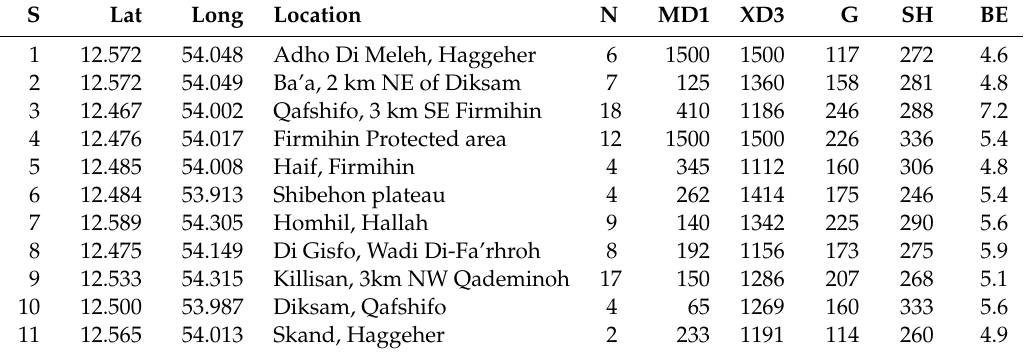
Table 1. Details of the sites and variables measured in Dracanea cinnabari Balf.f. trees with reptiles. The code of the sites (S) where D. cinnabari were sampled, its coordinates (latitude (Lat) and longitude (Long), in decimal degrees, WGS84), and location names are listed. The total number of reptiles species found on trees (N), the average minimum distance from the tree with reptiles to the closest tree (MD1), the average distance to the three closest trees (XD3), the average girth at 1 m height, the average stem height (SH), and the average number of branching events (BE) are detailed per